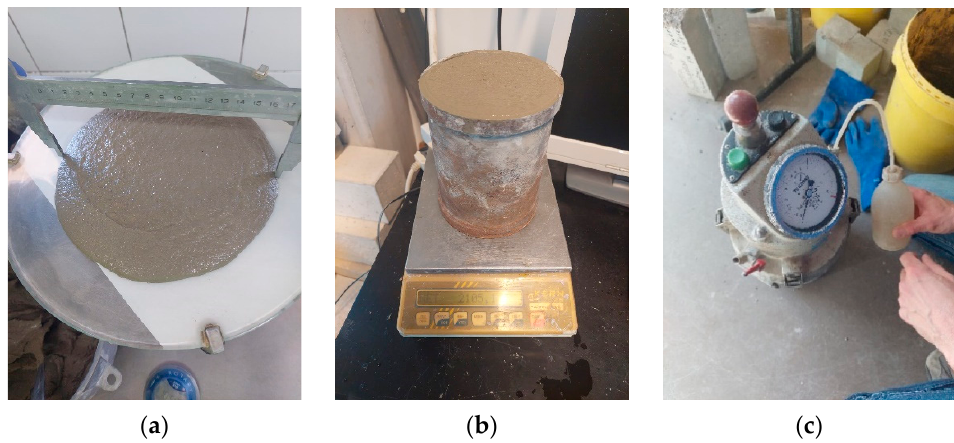
Figure 3. Fresh state property testing: mini cone slump ( a ), density ( b ), and air content ( c ).